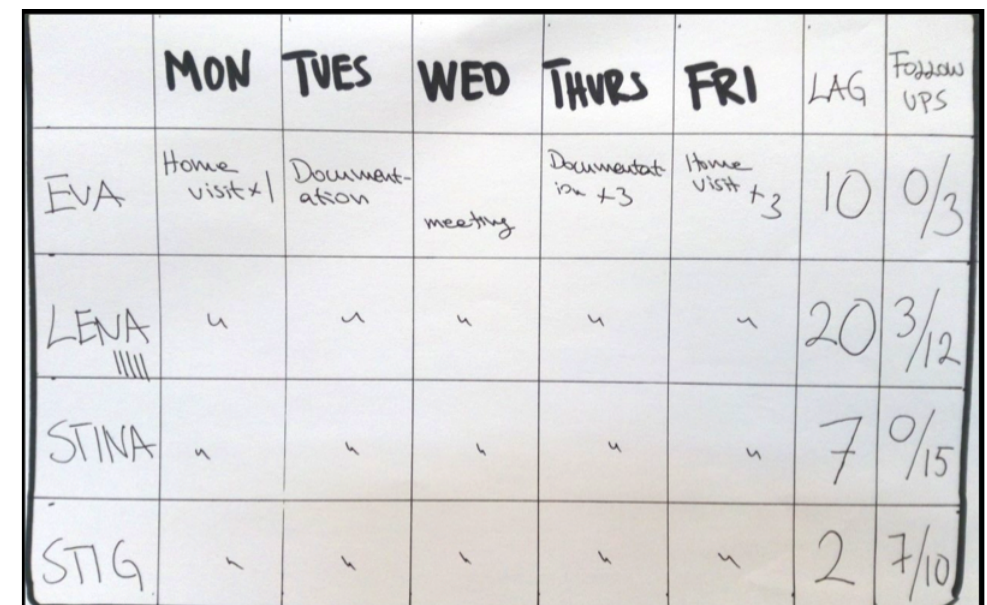
Figure 2. Simplified